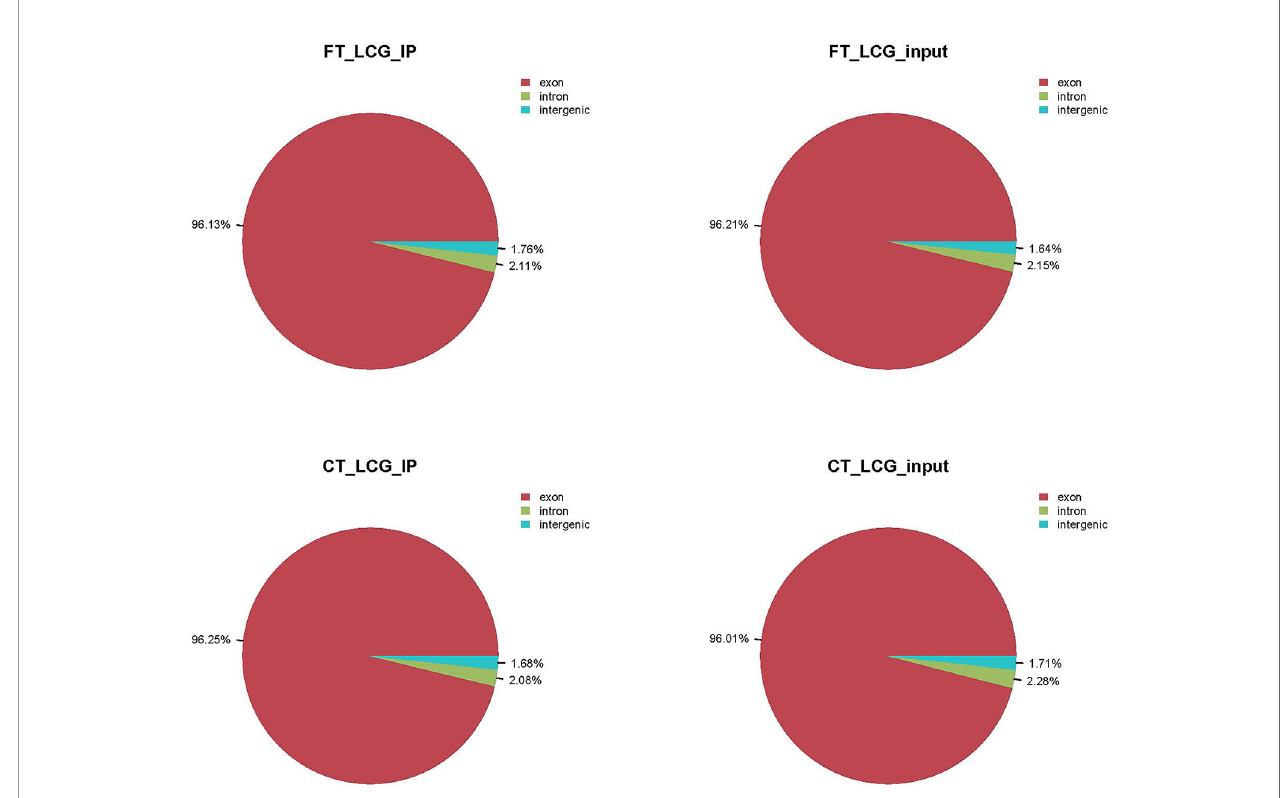
FIGURE 1 | Refer to the genome to compare the regional